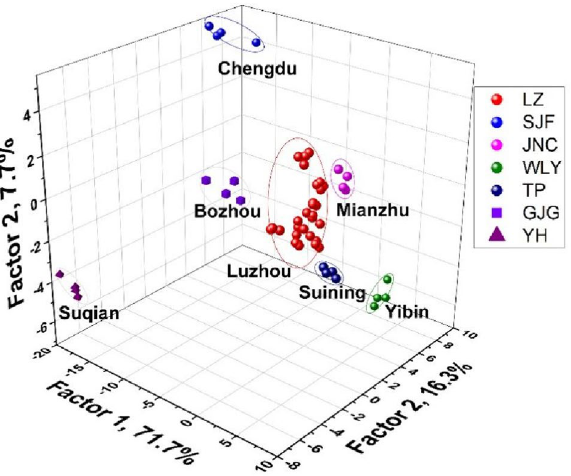
Figure 7. 3D canonical score plot for the first three factors of 7 origins obtained using the sensor array based on AA@AuNPs under the two pH conditions.